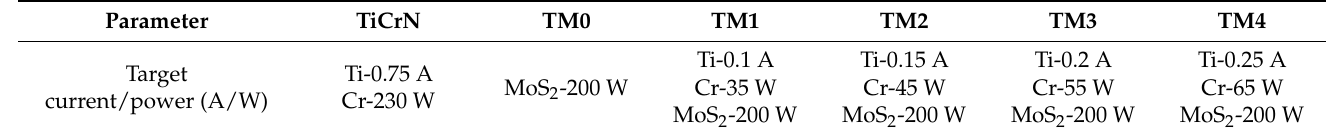
Figure 1. The structure of the coatings: ( a ) TiCrN, ( b ) TiCrN/MoS 2 and ( c ) TiCrN/MoS 2 –TiCr coatings. Table 1. Magnetron sputtering parameters of coating top layer.